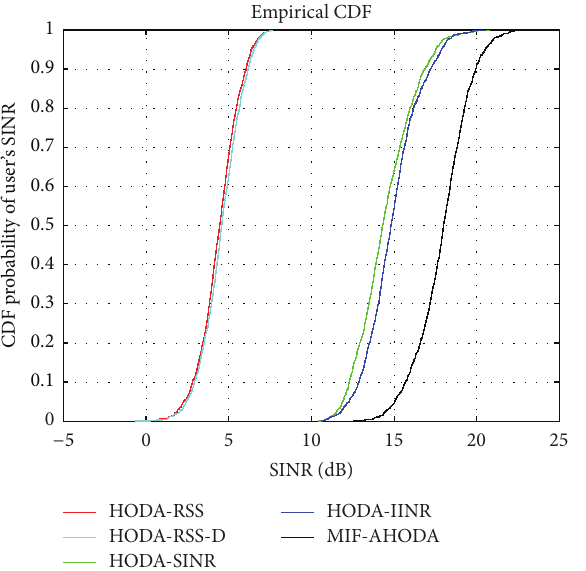
Figure 7: User’s outage